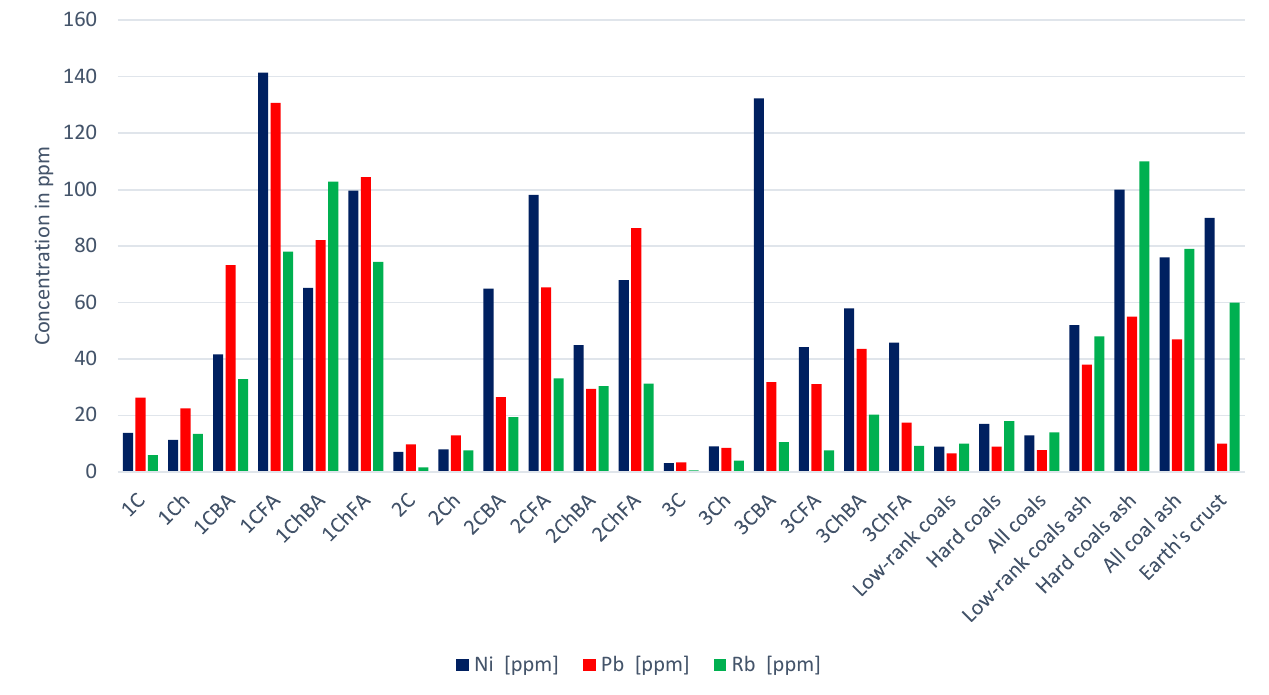
Figure 9. The Ag and In content of coal, char, and ashes and their Clarke values [21]. Figure 9. The Ni, Pb, and Rb content of coal, char, and ashes and their Clarke values